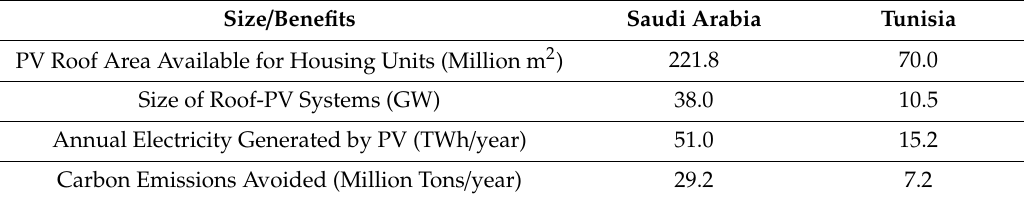
Table 25. Size and benefits of photovoltaic (PV) systems installed on roofs of the entire existing residential buildings in Saudi Arabia and